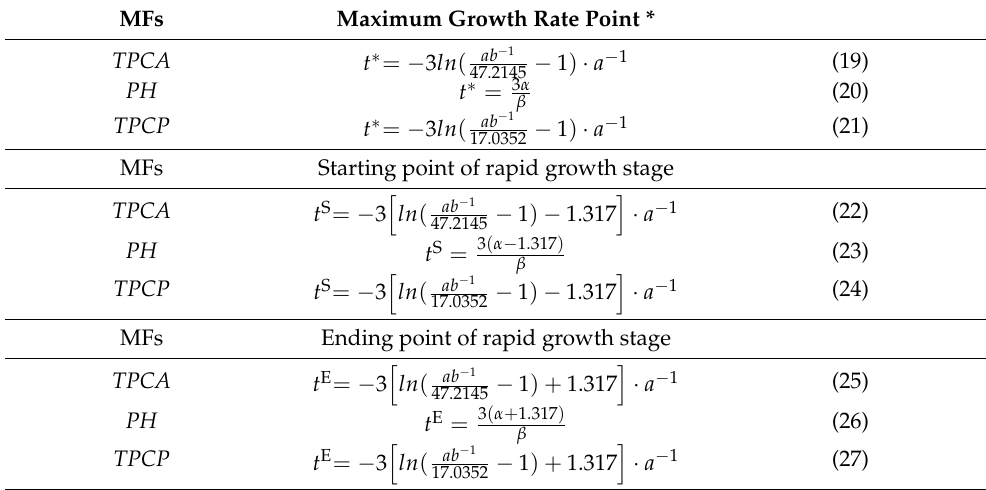
Table 4. Formulas for inflection points and rapid growth stages.